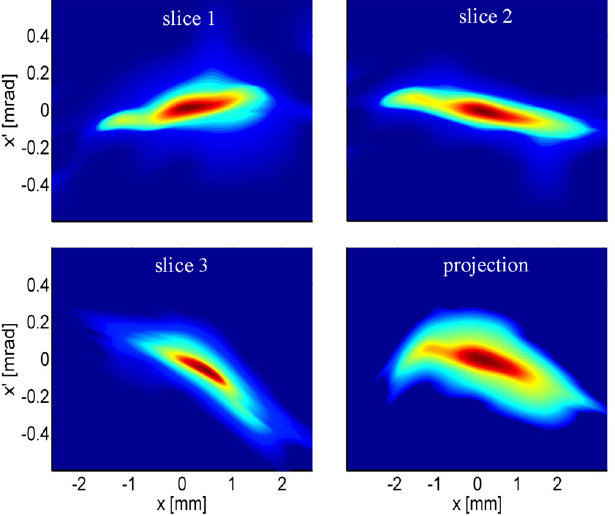
FIG. 7. (a) Streaked beam distribution with the gap of the downstream CS reduced to 1.4 mm; (b) Phase space ellipses for the front five slices (from bunch head to bunch center); (c) Phase space ellipses for the latter five slices (from bunch center to bunch